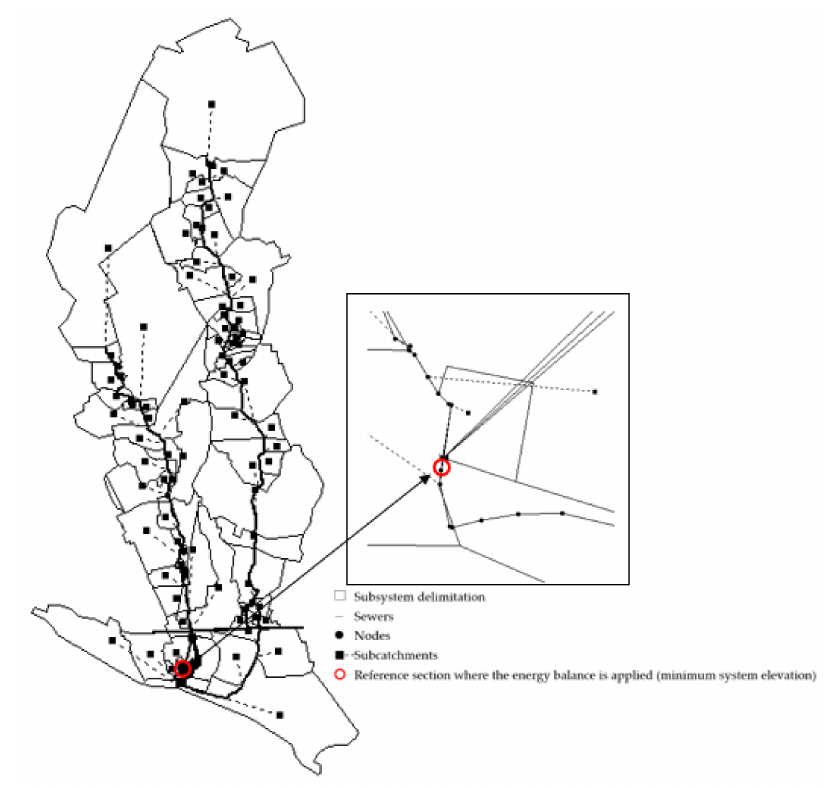
Figure 2. Network scheme of the selected